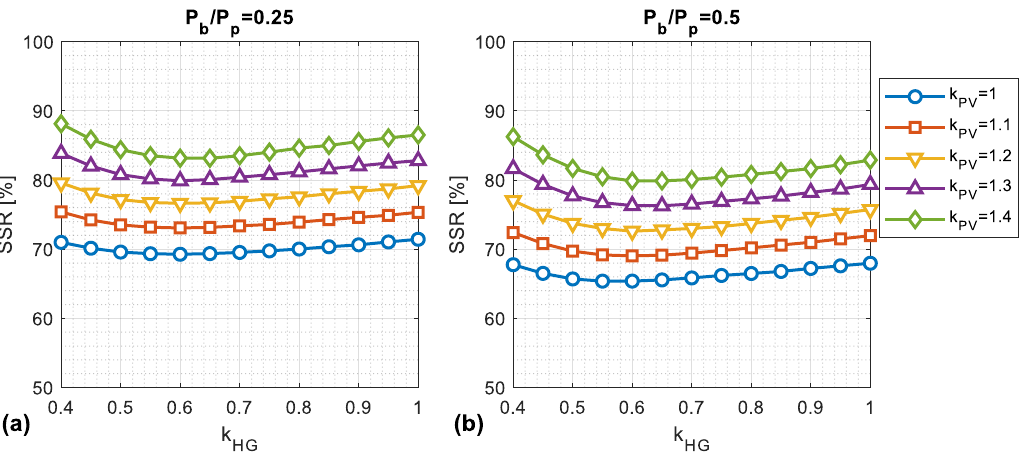
Figure 10. Hydrogen-based plant self-sufficiency ratio as a function of k HG and different k PV values for ( a ) P b /P p = 0.25 and ( b ) P b /P p = 0.5.